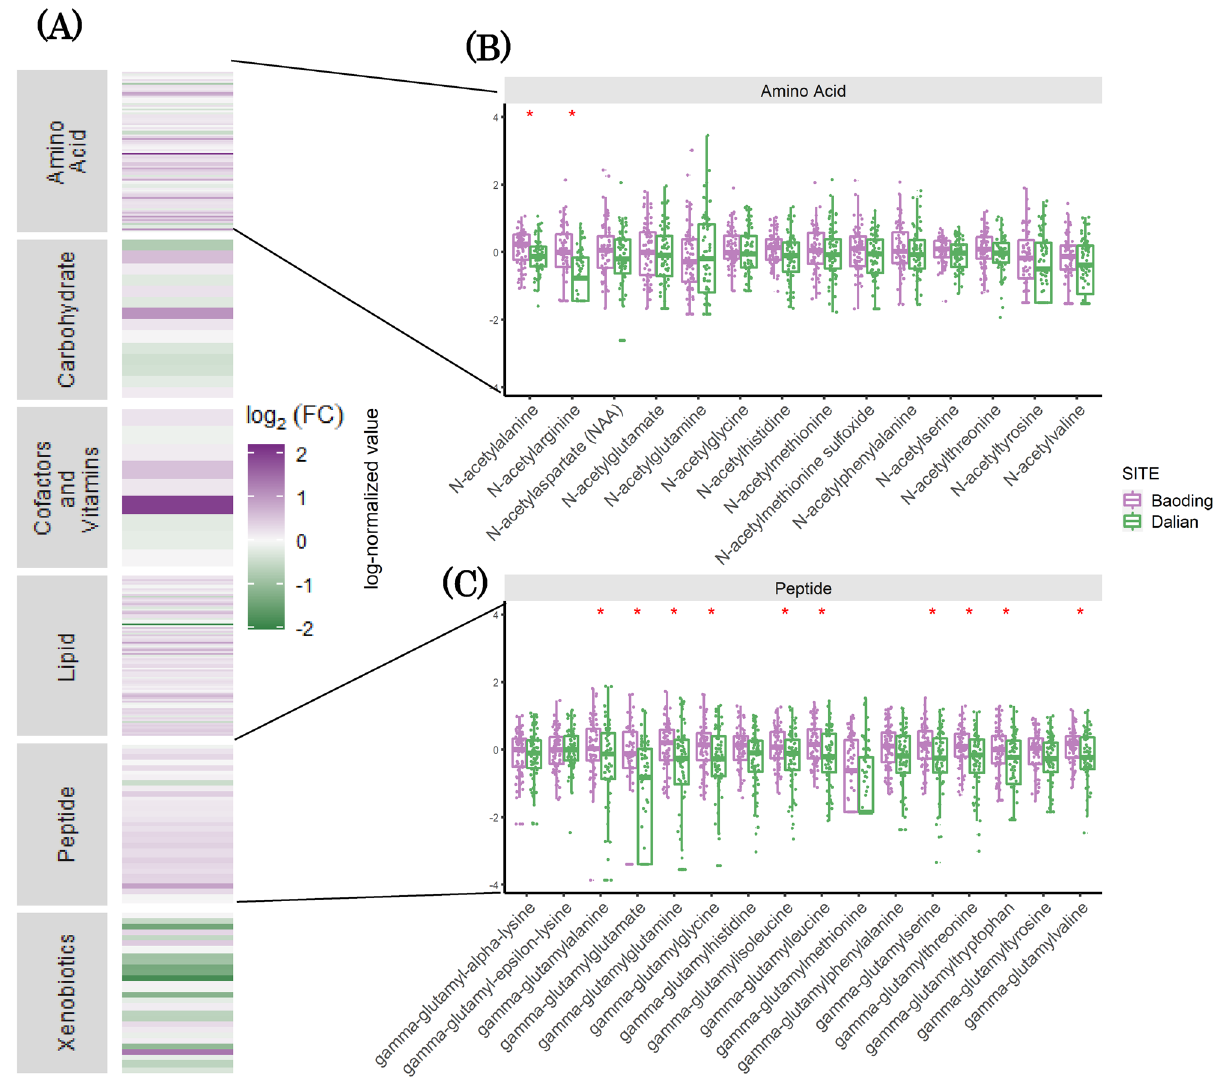
Figure 1. Metabolite pathways that are differentially modulated in skin samples of individuals from polluted city of Baoding. ( A ) Heatmap of log 2 of Fold Change between Baoding (More Polluted) and Dalian (Less Polluted), positive values indicate a higher amount in Baoding and negative values a higher amount in Dalian. ( B ) Focus on N-acetyle amino acids with boxplots of log normalized values, colored by site. ( C ) Focus on gamma-glutamyl amino acids with boxplots of log normalized values, colored by site. A red star indicates, for a given metabolite, that the difference in mean between the 2 cities is significant (q-value < 0.05, t-test with correction for multiple testing using Benjamini–Hochberg method). Figures were created using the R software: R Core Team (2017), R Foundation for Statistical Computing, Vienna, Austria. URL https:// www.R- proje ct.